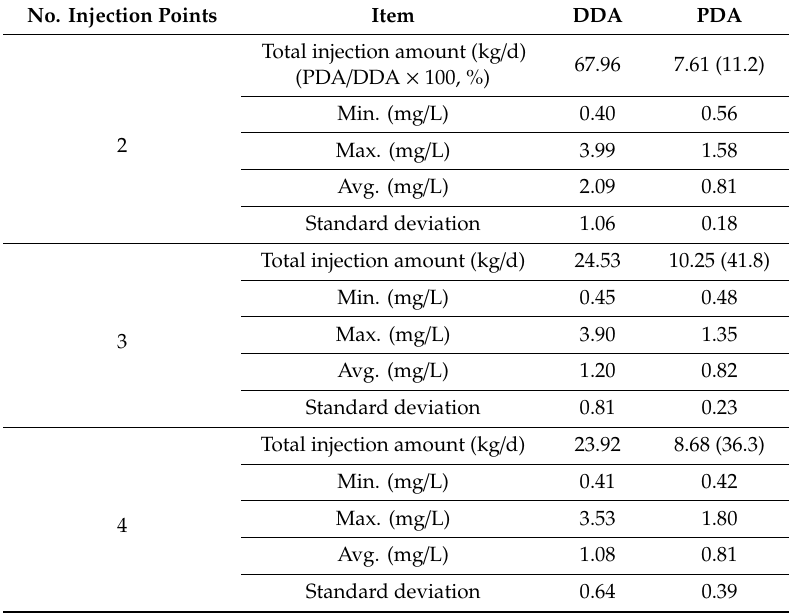
Table 4. Water-quality results of DDA and PDA under normal conditions.